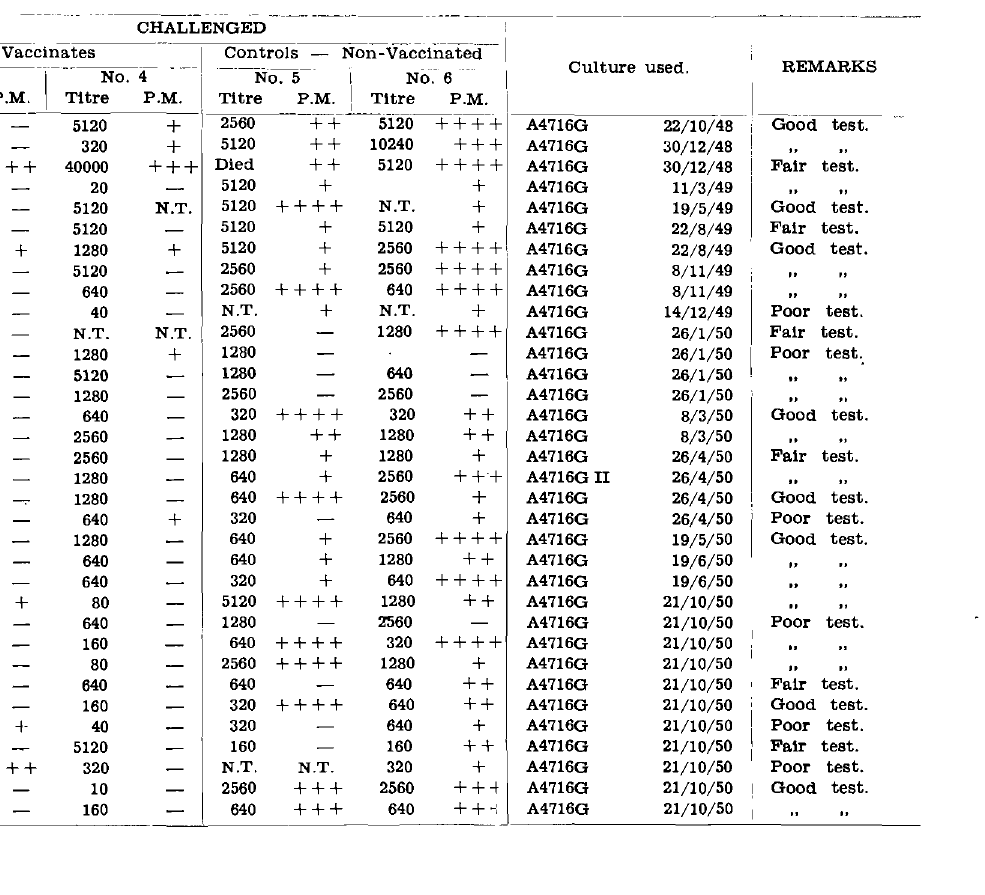
SAFETY TESTS AND IMMUNIZING VALUE TESTS WITH BRUCELLA VACCINE IN